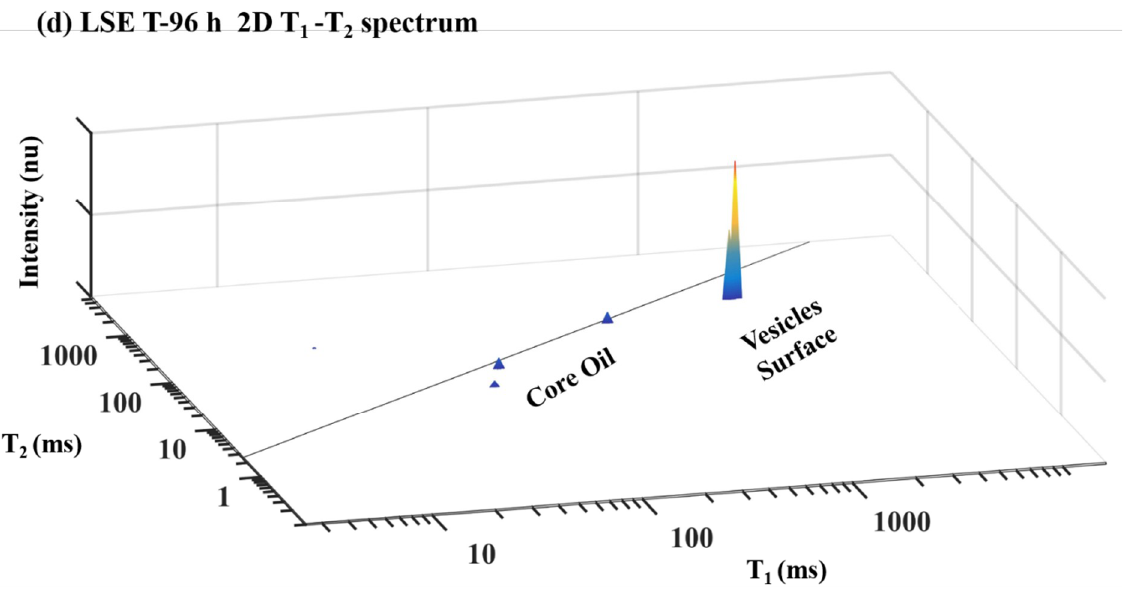
Figure 15. 1 H LF NMR relaxation spectra of LSE fresh produced (T-0 h a , b ) and after 96 h of thermal oxidation at 55 ◦ C (T-96 h, c , d ). Two-dimensional T 1 -T 2 peaks values and proposed 1 H TD assignment are shown in Table 3. Table 3. Numerical values of T 1 ‐T 2 of LSE and proposed 1 H TD assignment.